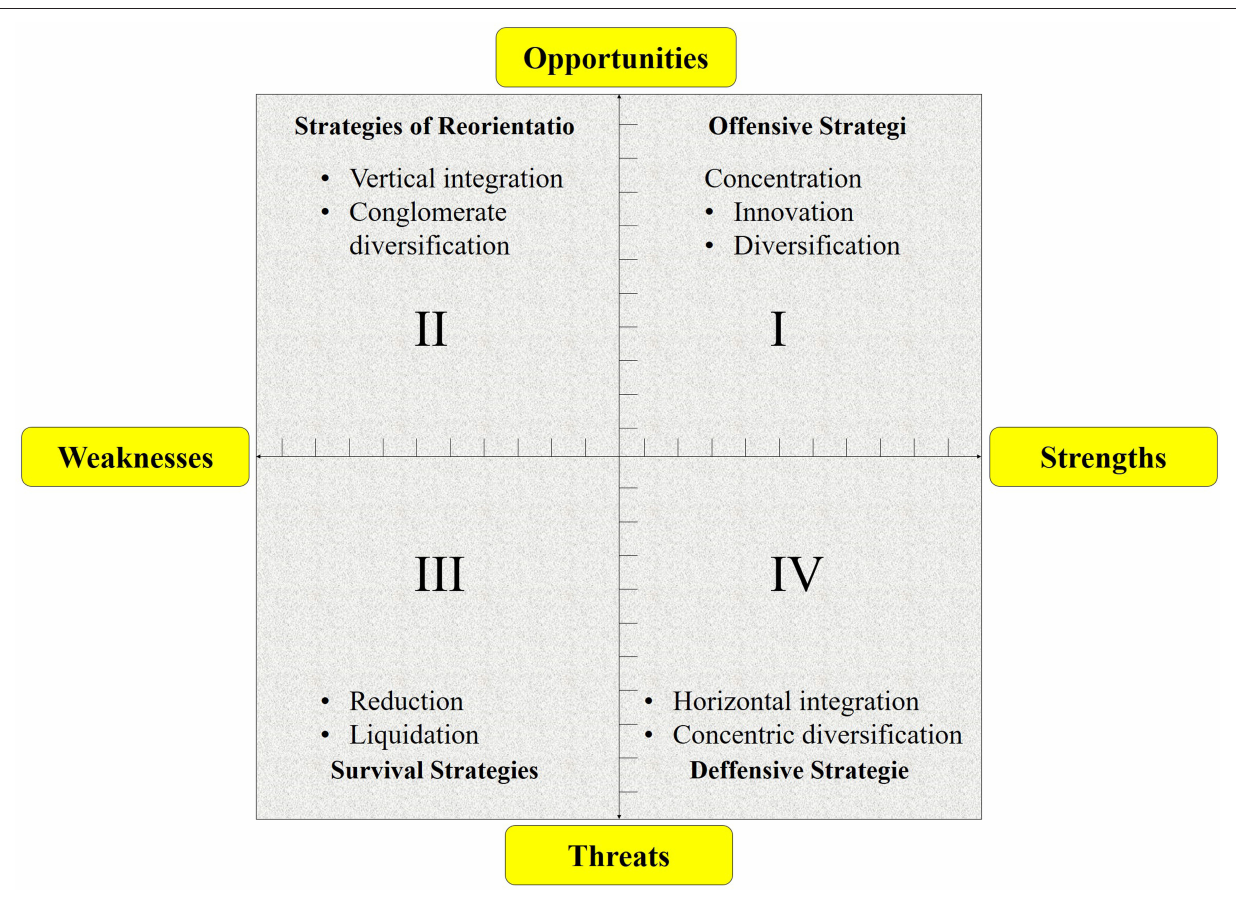
Frontiers in Sustainability |